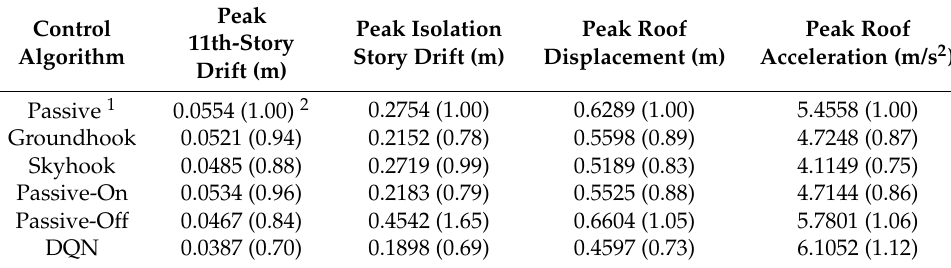
Table 3. Comparison of peak responses according to control algorithms